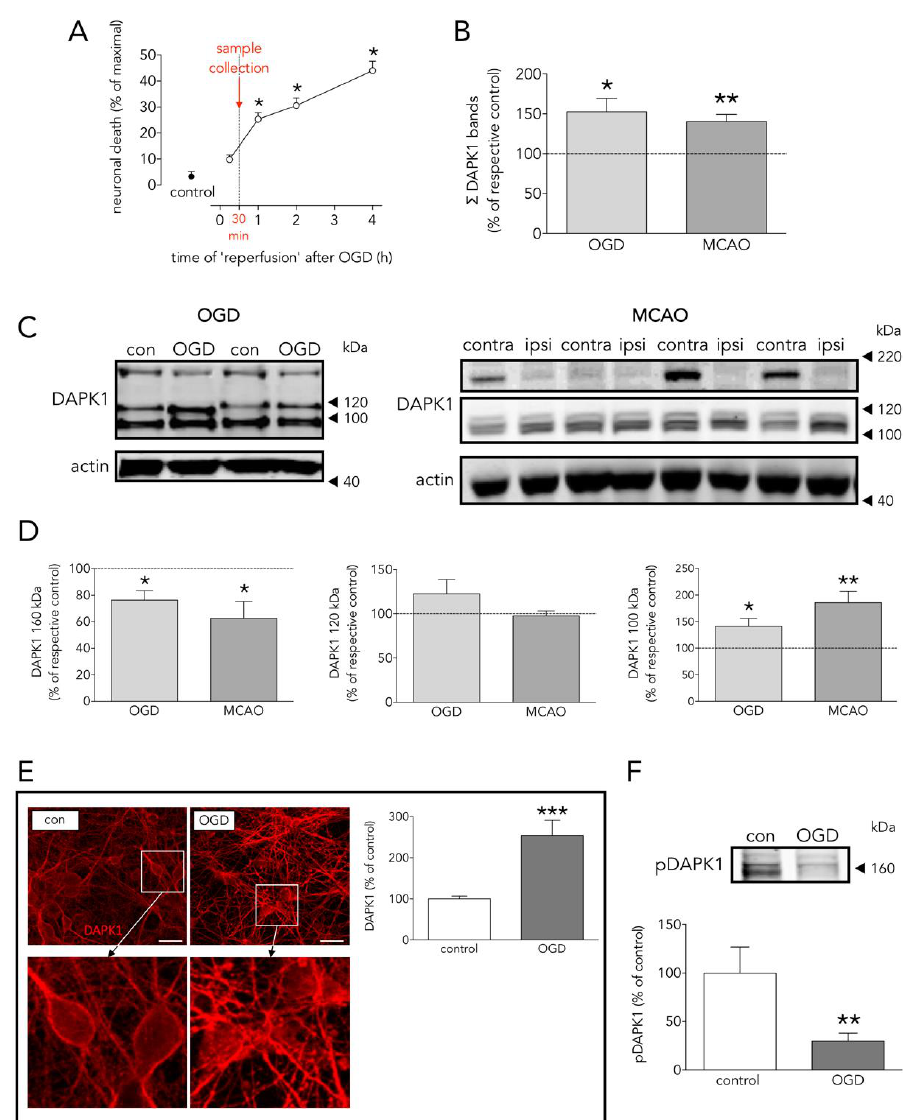
Figure 1. E ff ects of OGD on neuronal death, and DAPK1 expression, cleavage, and dephosphorylation. ( A ) E ff ect of time of ‘reperfusion’ after OGD on neuronal death; as depicted, experimental samples were taken at 30 min for further processing (one-way ANOVA plus SNK, n = at least 5 independent primary neuron culture preparations, with at least 3 technical replicates each). ( B ) E ff ect of OGD and MCAO on total DAPK1 levels (OGD: t test, n = 3 independent primary neuron culture preparations, with 3 technical replicates each; MCAO: paired t test, n = 9 rats, comparing ipsilateral (ipsi, ischemic) brain hemisphere with the contralateral (contra, control) one). ( C ) WB showing the e ff ect of OGD or MCAO on DAPK1 bands. ( D ) Quantification of the e ff ect of OGD or MCAO on DAPK1 cleavage and levels of the resulting bands (OGD: t test, n = 3 independent primary neuron culture preparations, with 3 technical replicates each; MCAO: paired t test, n = 9 rats, comparing ipsilateral (ipsi, ischemic) brain hemisphere with the contralateral (contra, control) one). ( E ) E ff ect of OGD on DAPK1 levels as measured by immunocytochemistry; insets in the upper pictures are shown magnified in the bottom pictures ( t test, n = 3 independent primary neuron culture preparations, with 5 technical replicates each). ( F ) WB and quantification of the e ff ect of OGD on pDAPK1 levels ( t test, n = 3 independent primary neuron culture preparations, with 3 technical replicates each). Results are shown as the mean and SEM. * p < 0.05, ** p < 0.01, *** p < 0.005 vs. respective control in all graphs. Scale bar: 30 µ m. Note that in ( B ), total DAPK1 levels represent protein